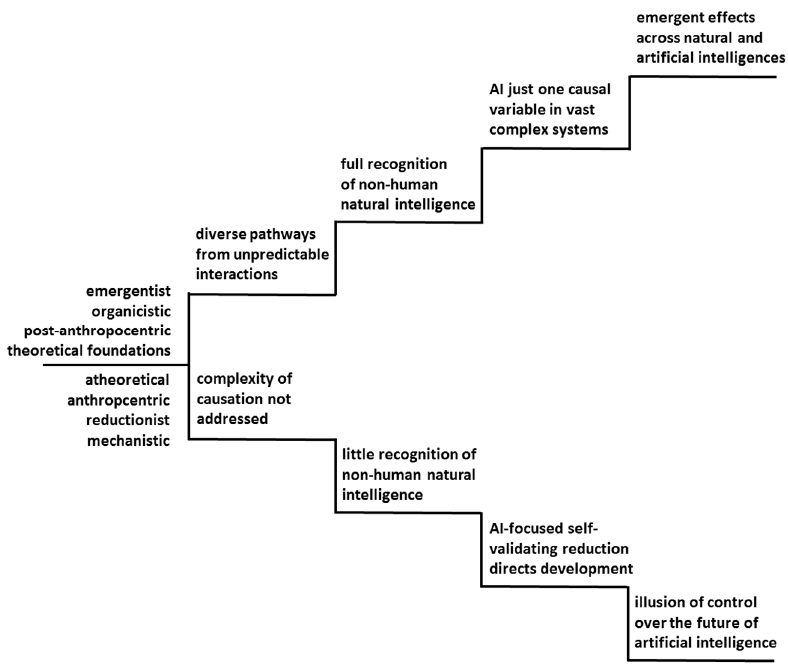
Figure 3. Comparison of alternative framings.